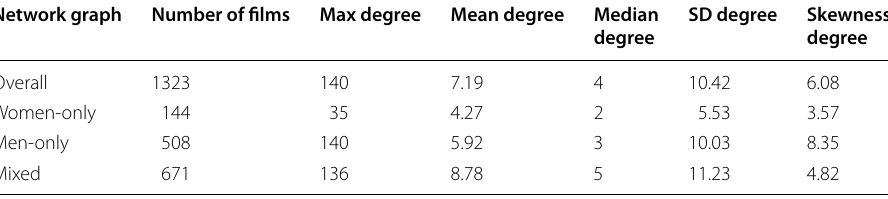
SD degree Skewness degree degree